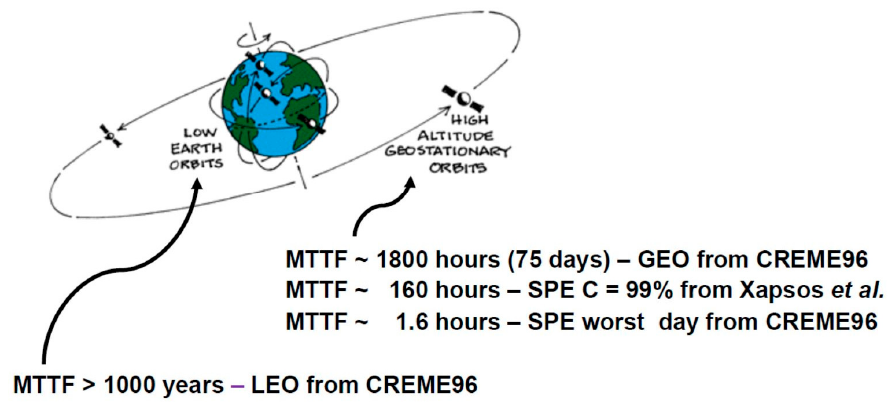
Figure 3. SEB failure rate for two potential orbits for a 1200 V SiC power MOSFET. Image from Department of Commerce, National Oceanic and Atmospheric Administration.